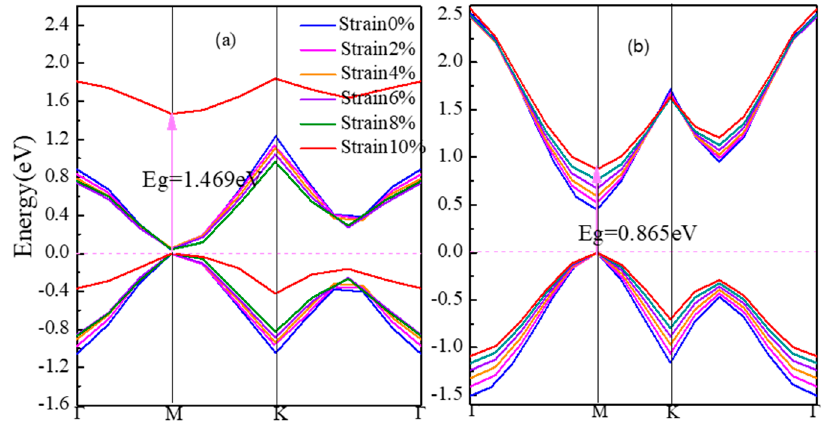
Figure 3. The band gap of strained graphynes ( a ) β -graphyne, ( b ) γ -graphyne.